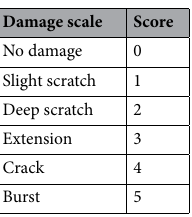
Table 3. Corresponding score to each damage